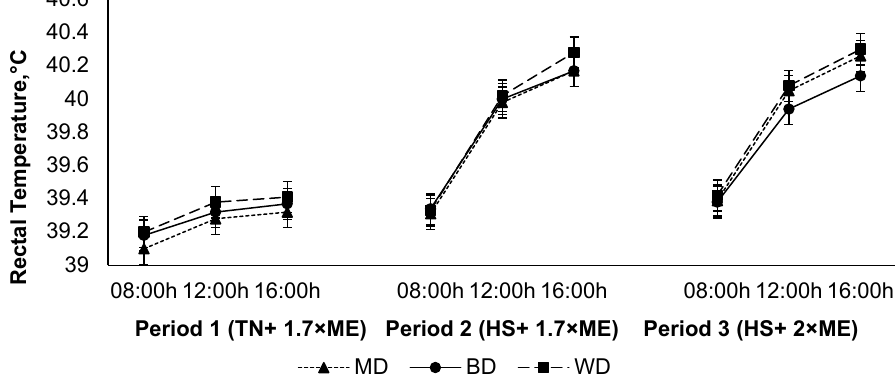
Figure 5. Relationship between rectal temperature, time of observation, and experimental period in sheep fed on different diets. The standard error of the difference for the interaction between period and dietary treatments and time is displayed on the graph. The p -values for the effects of diet, period, time, diet * period, diet * time, period * time, and diet * period * time were and p = 0.74, p < 0.001, p < 0.001, p < 0.05, p = 0.39, p < 0.001, and p = 0.96. The left and right flank temperatures responded qualitatively similarly, although the LFT was higher than the RFT (39.08 and 38.99 (SED 0.019) °C for the LFT and the RFT, respectively, p < 0.001). The average flank temperature increased in response to HS (P1 vs. P2) and was further elevated in P3 (38.22, 39.37, and 39.51 (SED 0.023) °C for P1, P2, and